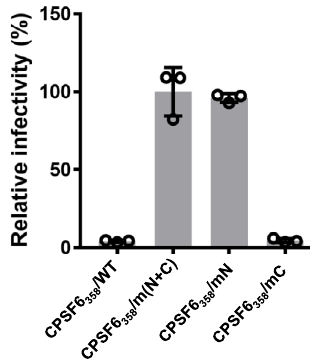
simulation fi ndings,whichrevealedcrucialrolesofboththeN-terminal LCRand15-merFGpeptideforbimodalbindingofCPSF6tohexameric CA lattices.